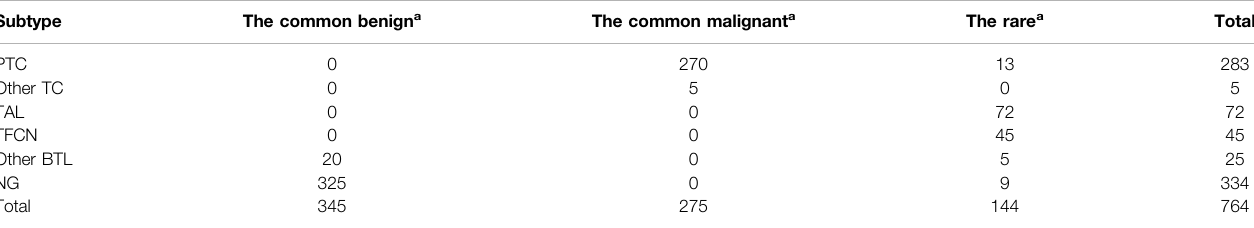
TABLE 3 | The test dataset in clinical practice was relabeled based on our binary classi fi cation results and the ground truth for evaluating the triple classi fi cation model performance. Subtype The common benign